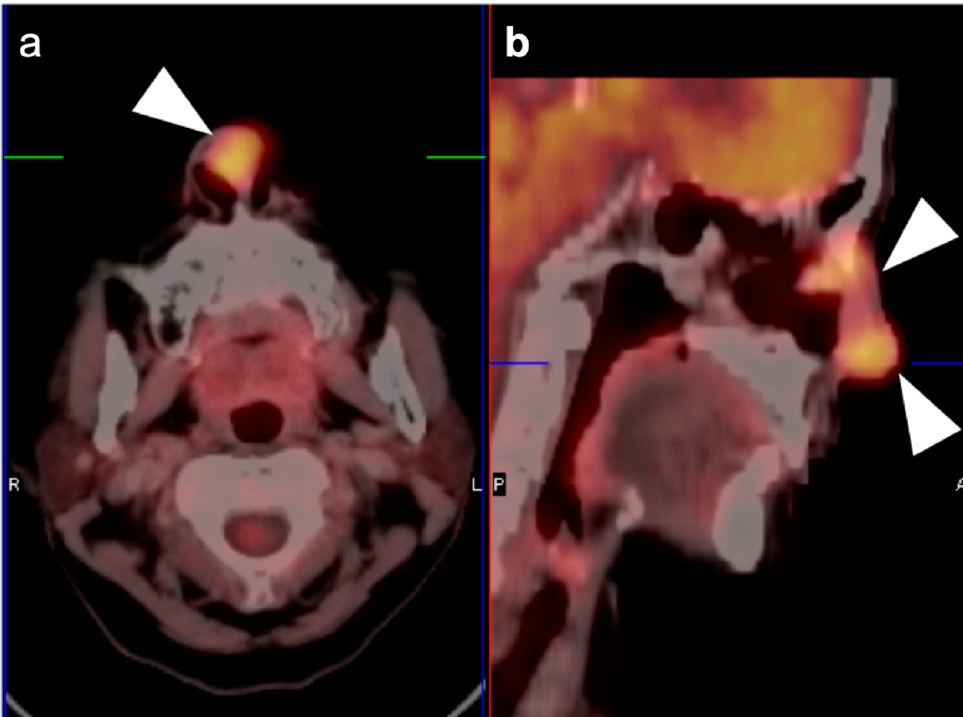
Figure 21. Sinonasal squamous cell carcinoma of the anterior nasal septum. ( a ) Axial FDG PET- CT image demonstrates a hypermetabolic tumor of the anteroinferior nasal septum (white arrow- head). ( b ) Sagittal FDG PET-CT image demonstrates that there is spread throughout the entire nose (white